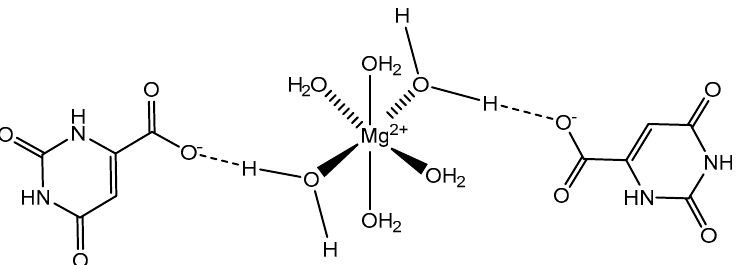
Figure 3. Structure of orotic acid.